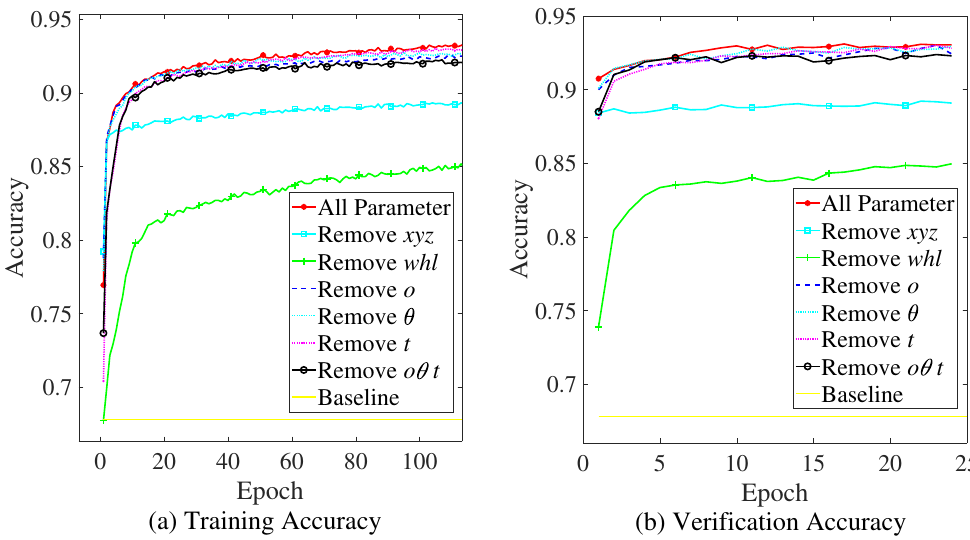
Figure 6. Training and validation accuracy of the control group. Table 3. Training and validation accuracy of the control group in the final